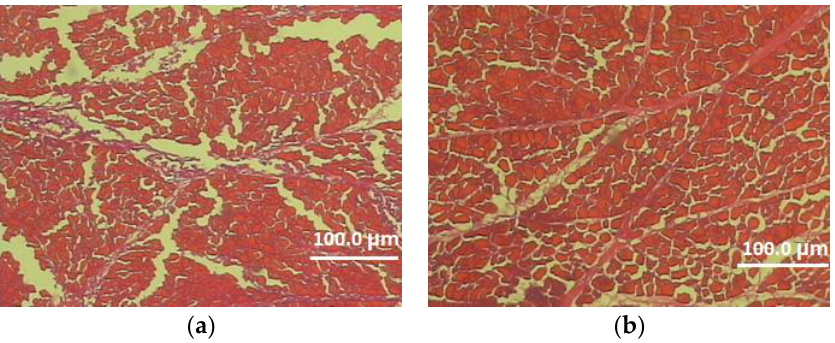
Figure 2. Cross-section of the superficial pectoral muscle of male ( a ) and female ( b ) 113-week-old Dworka D11 strain (magnification 100×).